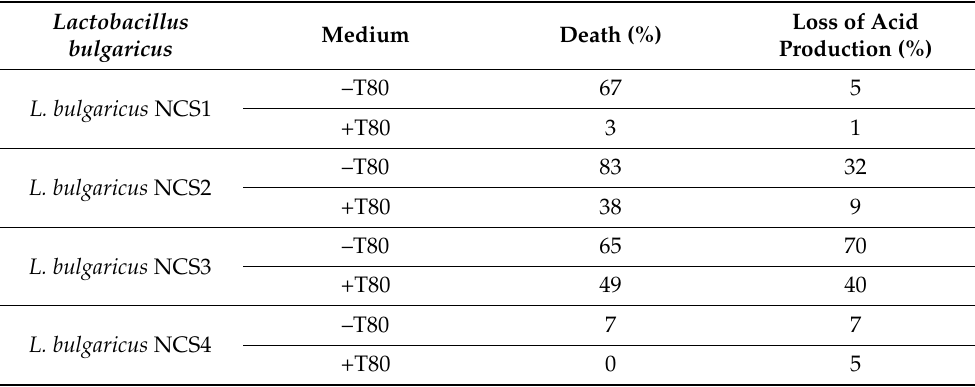
Table 2. Addition of Tween 80 to the medium and its effect on viability (data from Smittle et al., 1972)